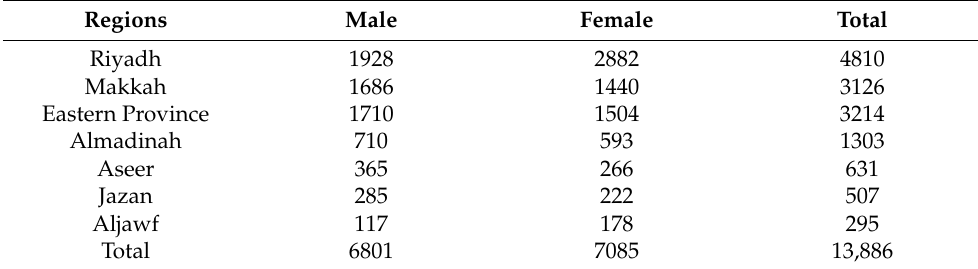
Table 1. Alif–Ya sample of tested students by region.